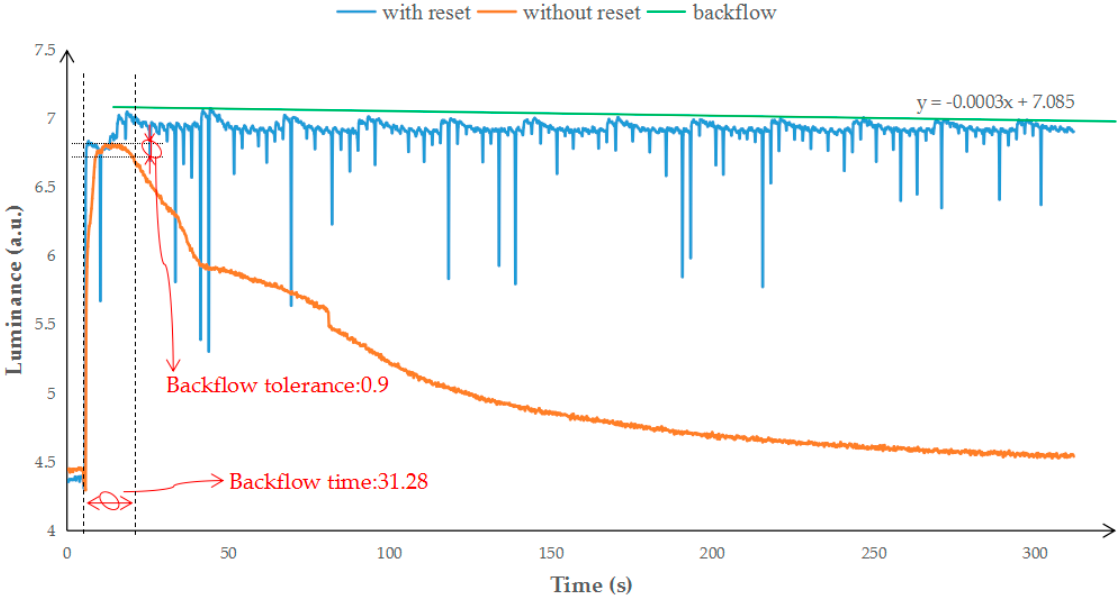
Figure 8. The relationship between the reflected brightness and time for different driving methods. The “with reset” curve is the brightness data, which are driven with the reset waveform. The “without reset” curve is the brightness data, which are driven with the traditional driving waveform. The linear backflow is used to evaluate the oil backflow speed.